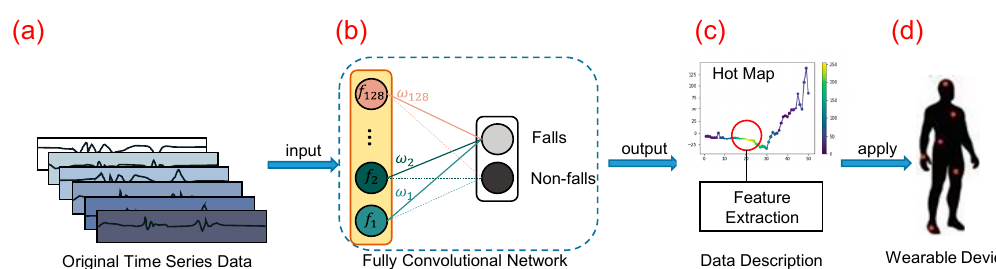
Figure 1. An overview of our proposed method. ( a ) The input of the convolutional neural network (CNN) is the original time series data. ( b ) We use CNN to train a high-accuracy pre-impact fall detection model. ( c ) Based on the class activation mapping (CAM) method, we obtain the hot map of the original time series, which highlights the contributing region. By analysis on this region in detail, we manually extract effective features and characteristics. ( d ) Combining threshold detection on the obtained feature region, the method can be applied to wearable devices with comparable accuracy.